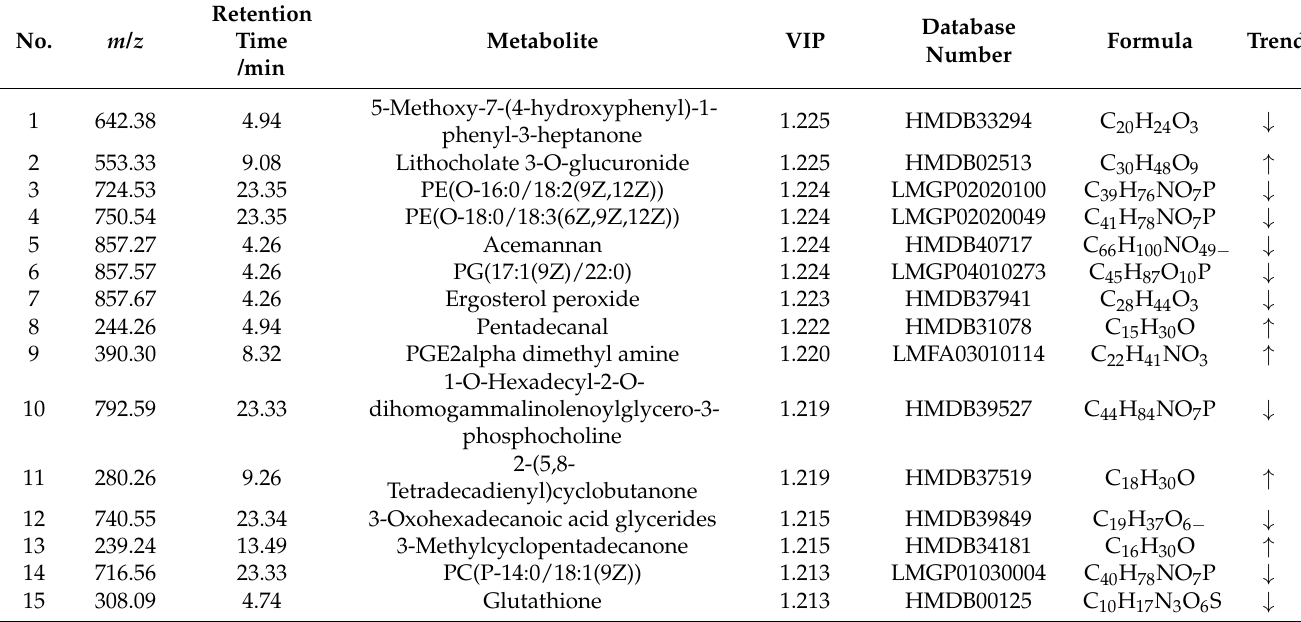
Table 2. Potential differential metabolites between the ox-LDL and NaPc groups.